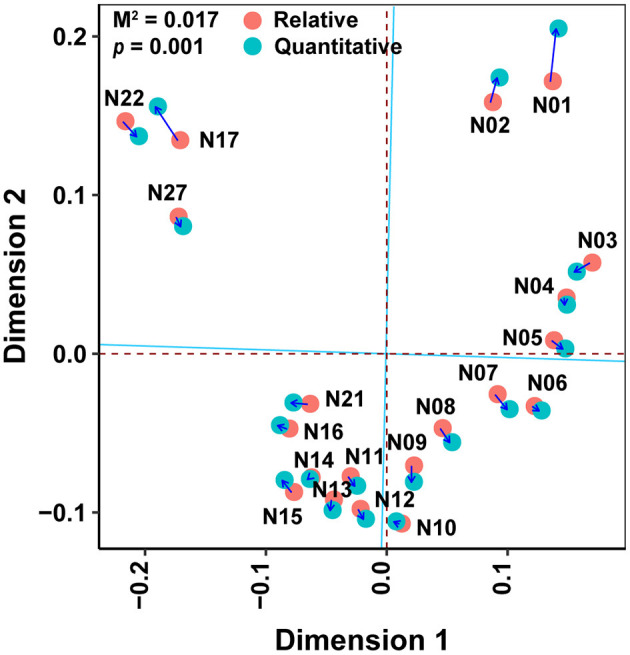
Procrustes analysis of relative abundance against quantitative abundance in presenting bacterial distribution patterns obtained from Principal Coordinates Analysis. Principal Coordinates Analysis based on Bray–Curtis distance of bacterial communities. The M2 that was approximated to zero indicated the remarkable agreement of comparison. The statistical significance was measured by the Monte Carlo test.